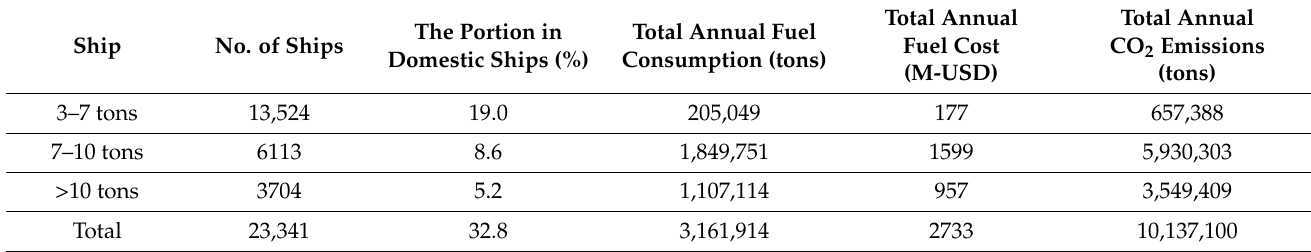
Table 6. Fishing boat yearly operating results in